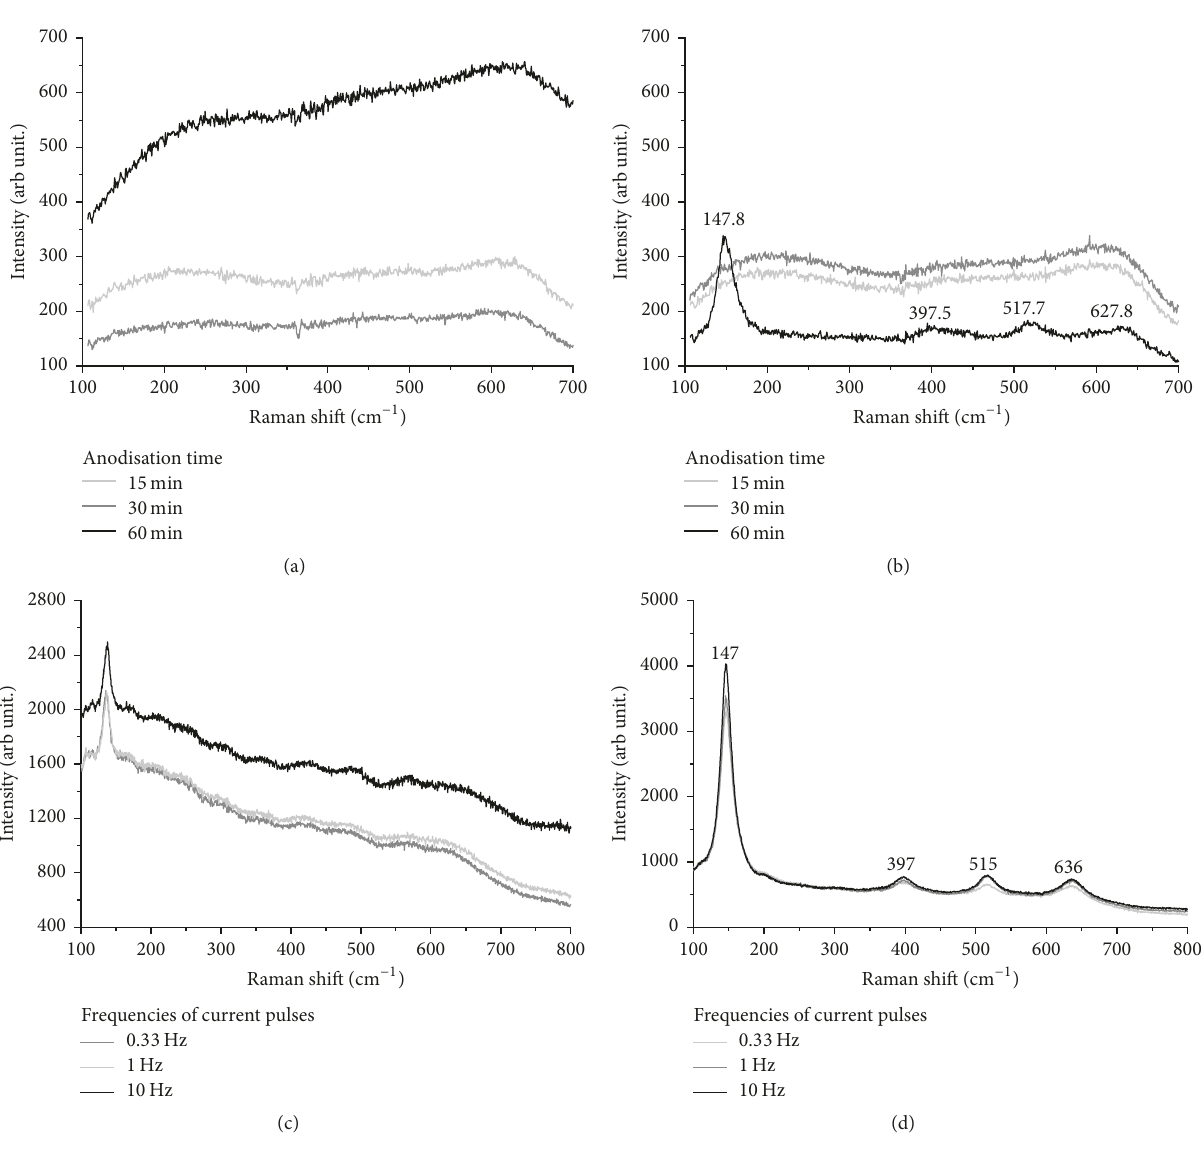
Figure 2: Raman spectra of formed films on electropolished (a, c) and nonelectropolished (b, d) titanium surfaces.